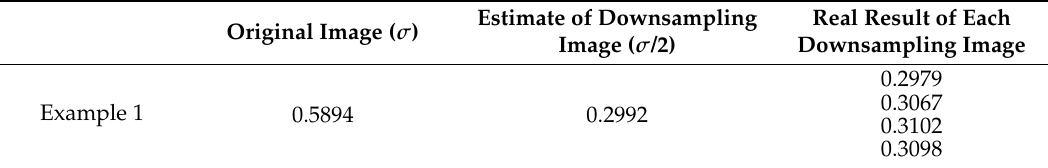
Table 2. Gaussian function parameter ( (cid:2026) ) of the image before and after downsampling.